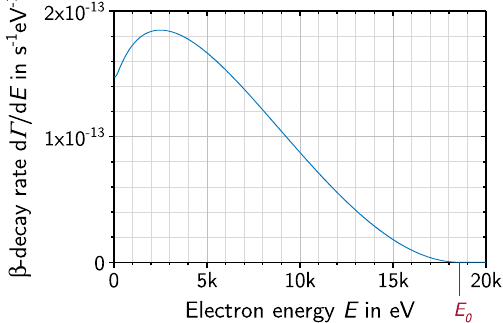
Fig. 1 The differential β -electron energy spectrum for the β -decay of moleculartritiumwiththeendpoint energy E 0 of18.574 keV.Thegiven units correspond to the decay rate of a single tritium nucleus